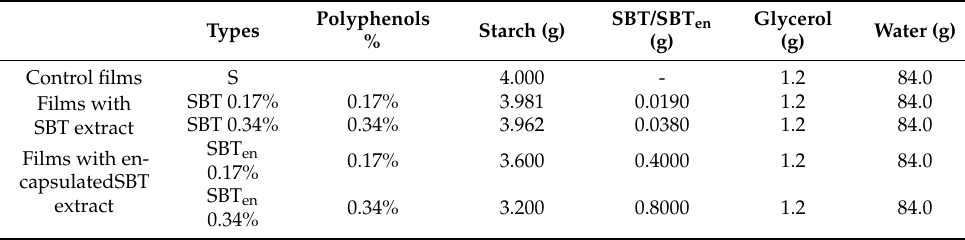
Table 3. Formulations of starch films incorporating free or encapsulated SBT